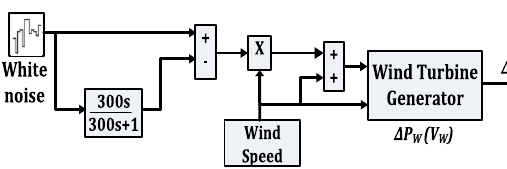
Fig. 3 The wind power model for LFC analysis using